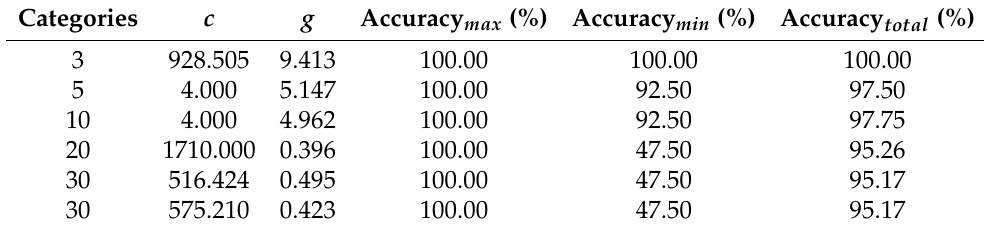
Table 6. Accuracy of different numbers of samples (MIT-BIH arrhythmia